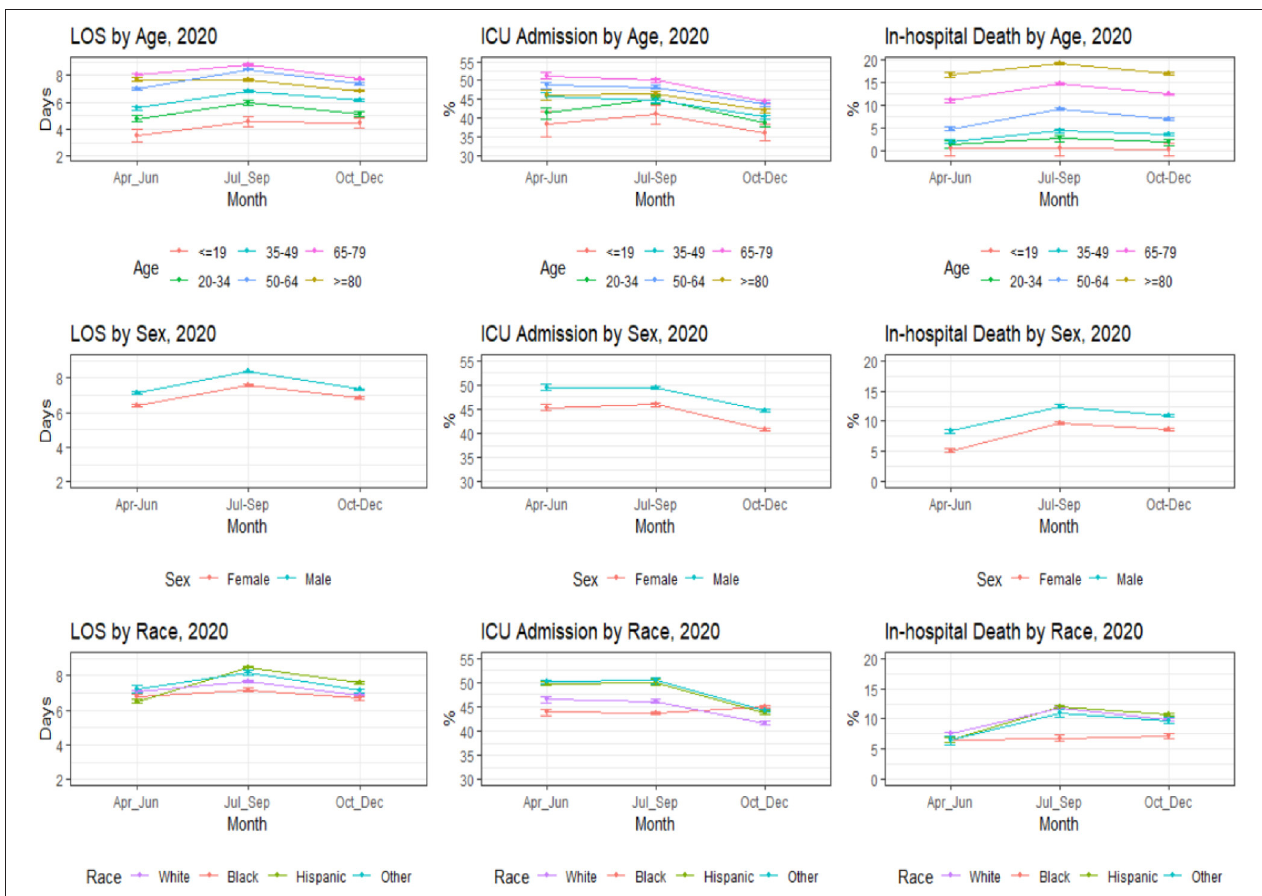
FIGURE 1 | Trends in LOS, ICU admission, and In-hospital death by age, sex, and